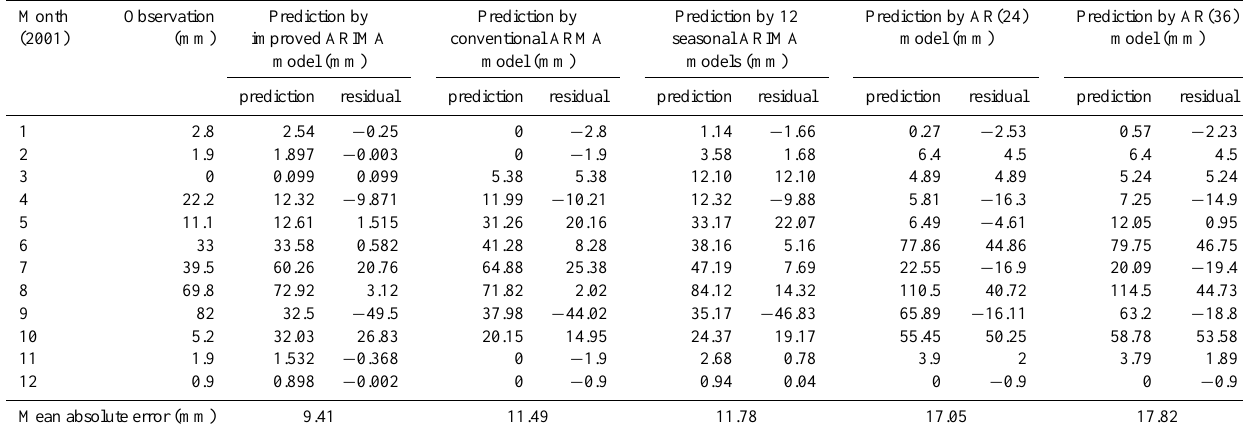
Table 6. Predicted monthly precipitation data for